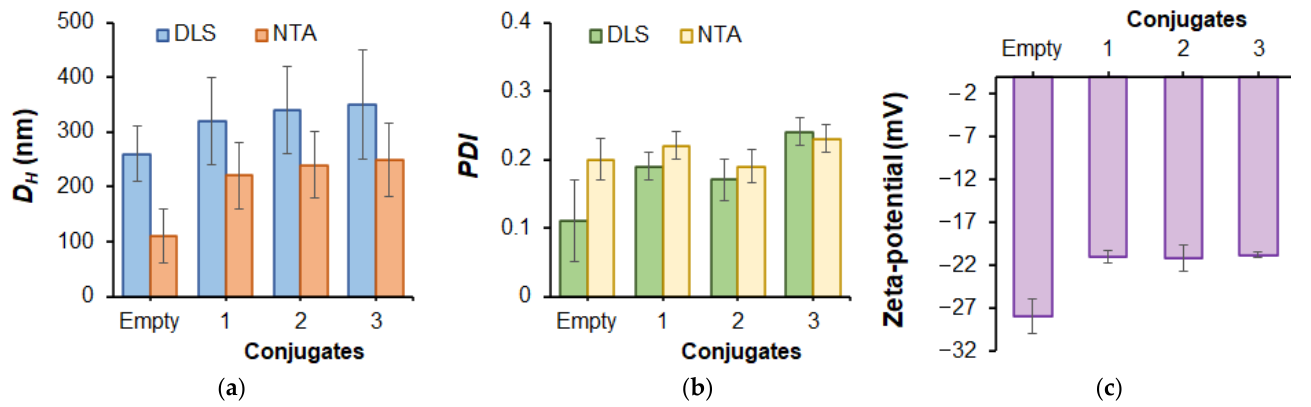
Figure 3. Characteristics of self-assembled empty P(Glu- co -Phe) and PMX B-conjugated nanoparticles determined by dynamic light scattering, nanoparticle tracking analysis and electrophoretic light scattering: hydrodynamic diameter ( D H ) ( a ), polydispersity index (PDI) ( b ) and zeta-potential ( c ). Conjugates differed by the amount of bound PMX B: 1–280 μ g/mg polymer; 2–312 μ g/mg polymer;